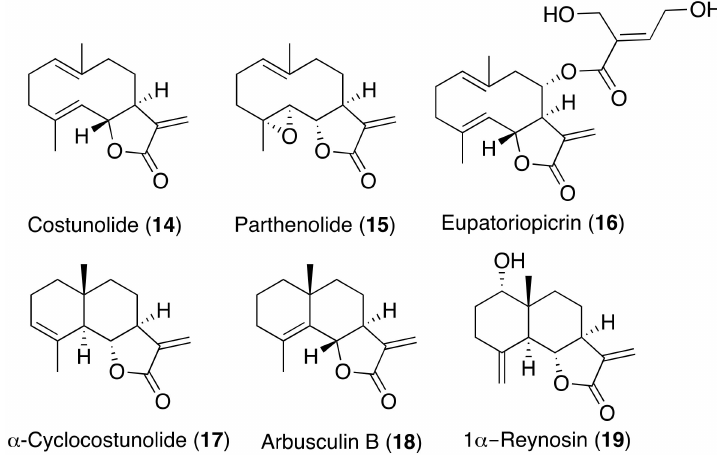
Figure 7. Sesquiterpene lactones from terrestrial sources with reported antikinetoplastid activity.